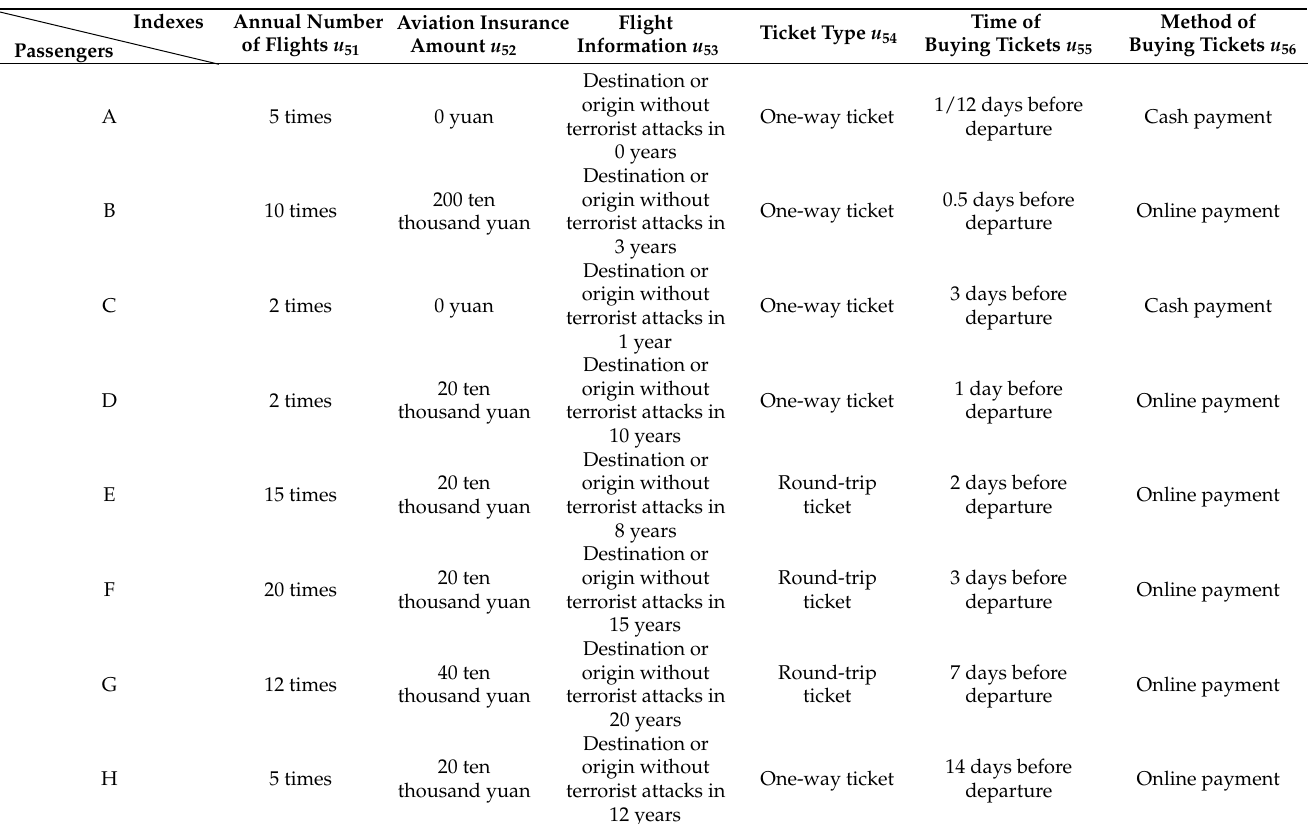
Table 18. Sample data of passengers (civil aviation travel record